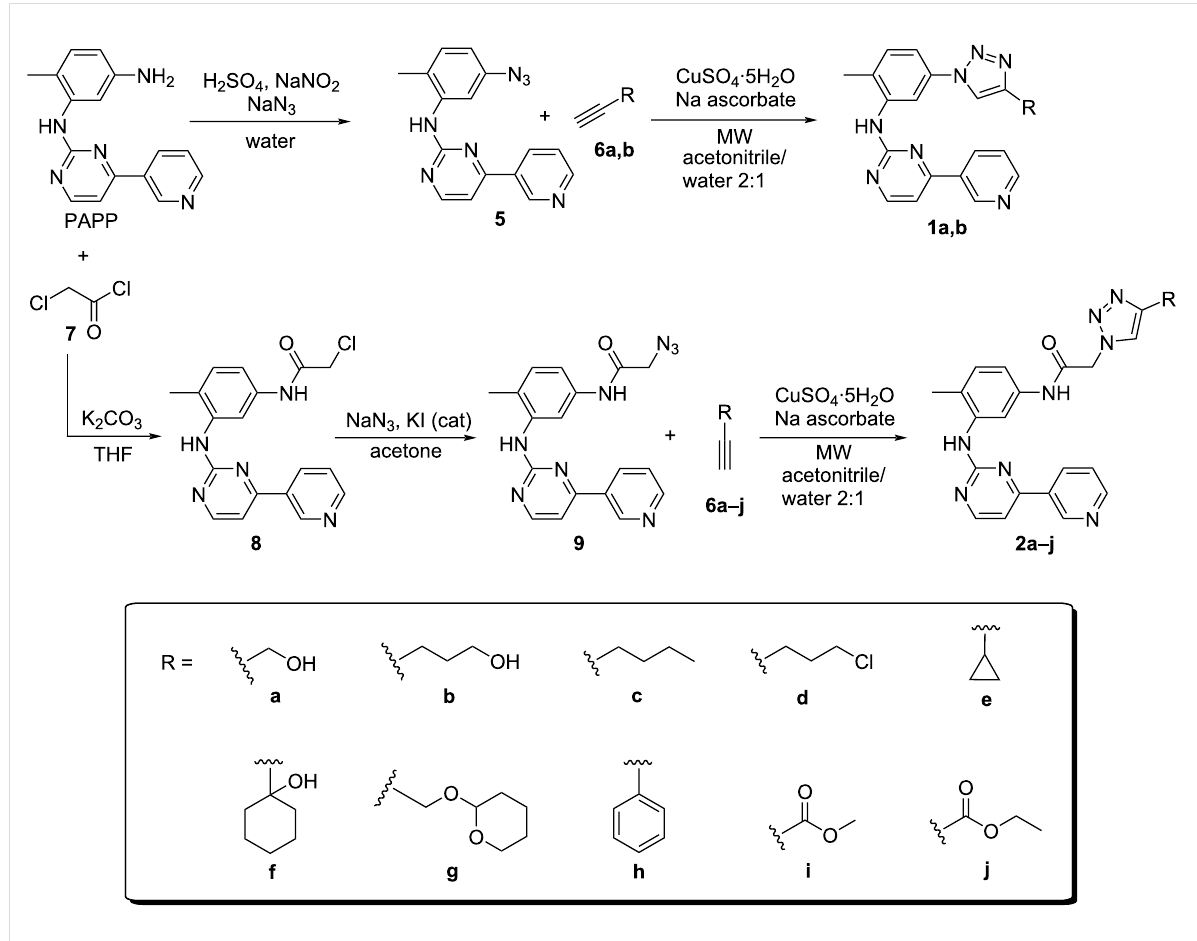
Scheme 1: Synthetic route of the triazole derivatives 1a , b , and 2a–j